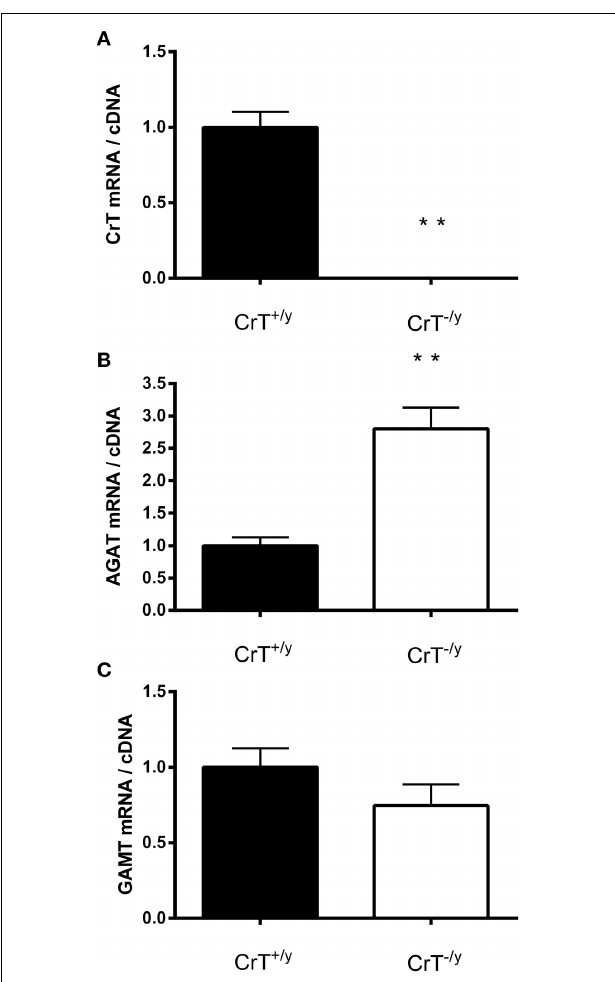
FIGURE 1 | Gene expression of (A) creatine transporter (CrT) and creatine synthesizing enzymes (B: AGAT and C: GAMT) in CrT + / y and CrT − / y gastrocnemius mice muscle. Values are means ± s.e.m., n = 10 per group. Different from CrT + / y ∗∗ P < 0 . 01.